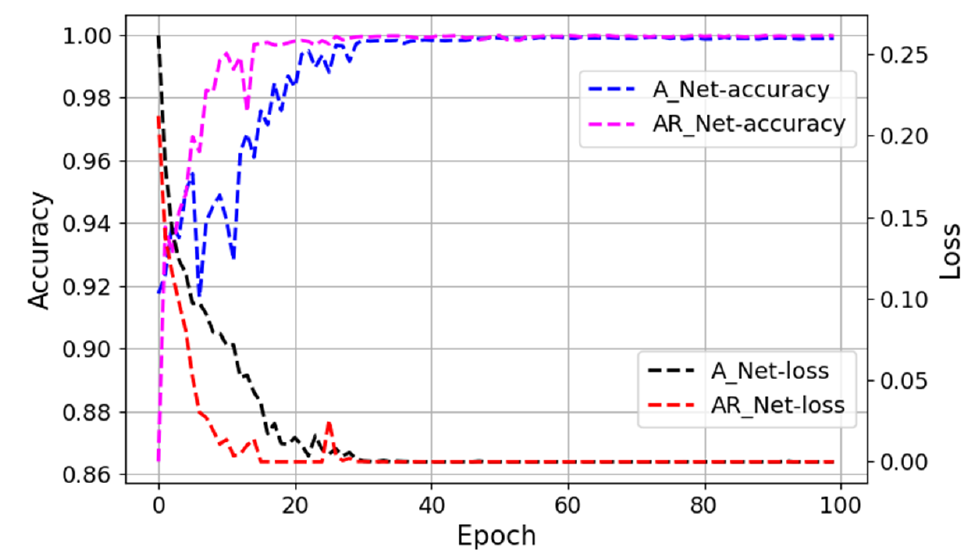
Figure 7. Curve of loss and accuracy on validation (effects of residual structure on the model).